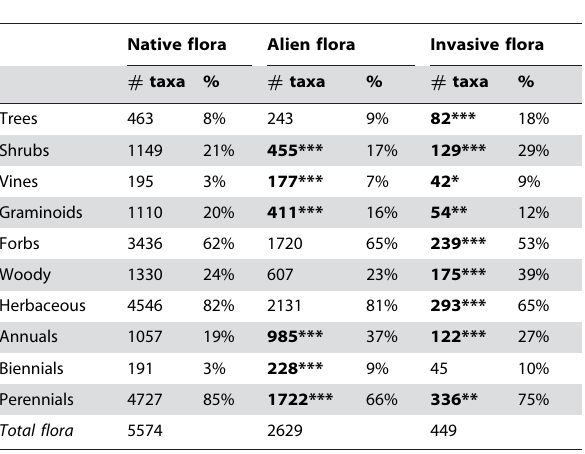
Table 4. The composition of native, alien, and invasive vascular plant floras of the Eastern U.S. with respect to growth habit and duration